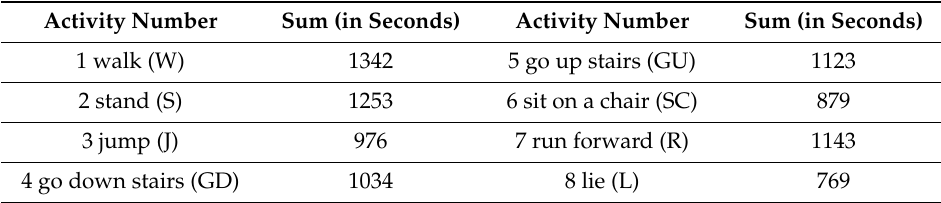
Figure 9. The triaxial accelerometer data of “go up stairs” from three subjects with large individual di ff erences: ( a ) Male, 177 cm, 83 kg; ( b ) Female, 162 cm, 45 kg; ( c ) Male, 172 cm, 60 kg. Table 3. Activities performed in the experiments.